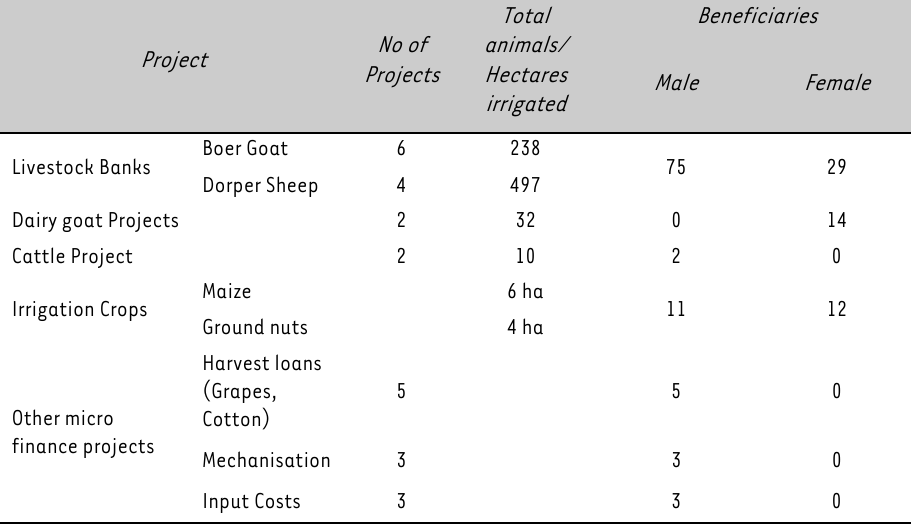
Beneficiaries Male